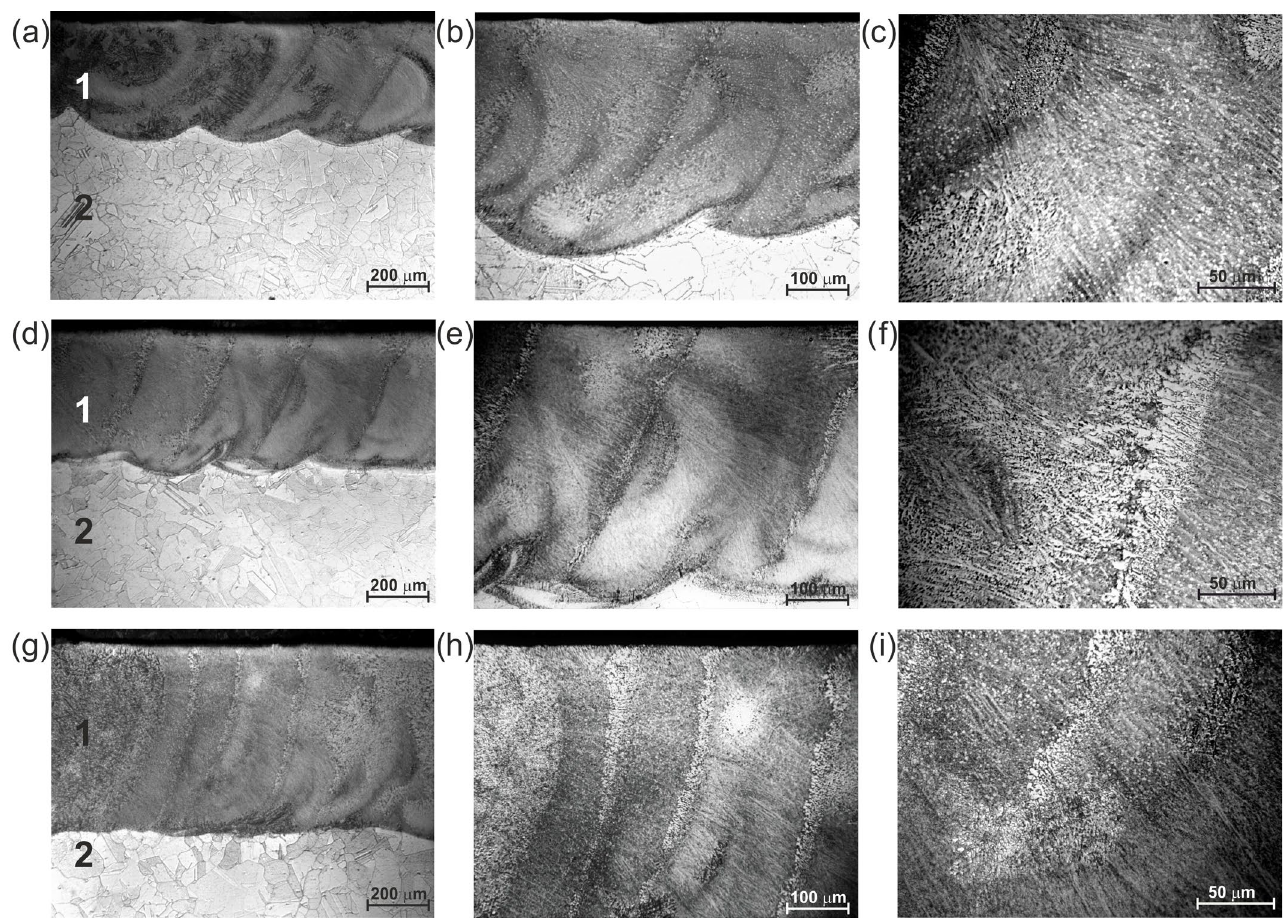
Figure 5. OM image of the cross-sections of the laser borided layers produced on Nimonic 80A alloy arranged as multiple tracks by using different laser beam power: ( a – c ) 1.3 kW; ( d – f ) 1.56 kW; ( g – i ) 1.95 kW. 1—laser re-melted layer; 2—substrate material (Nimonic 80A alloy).